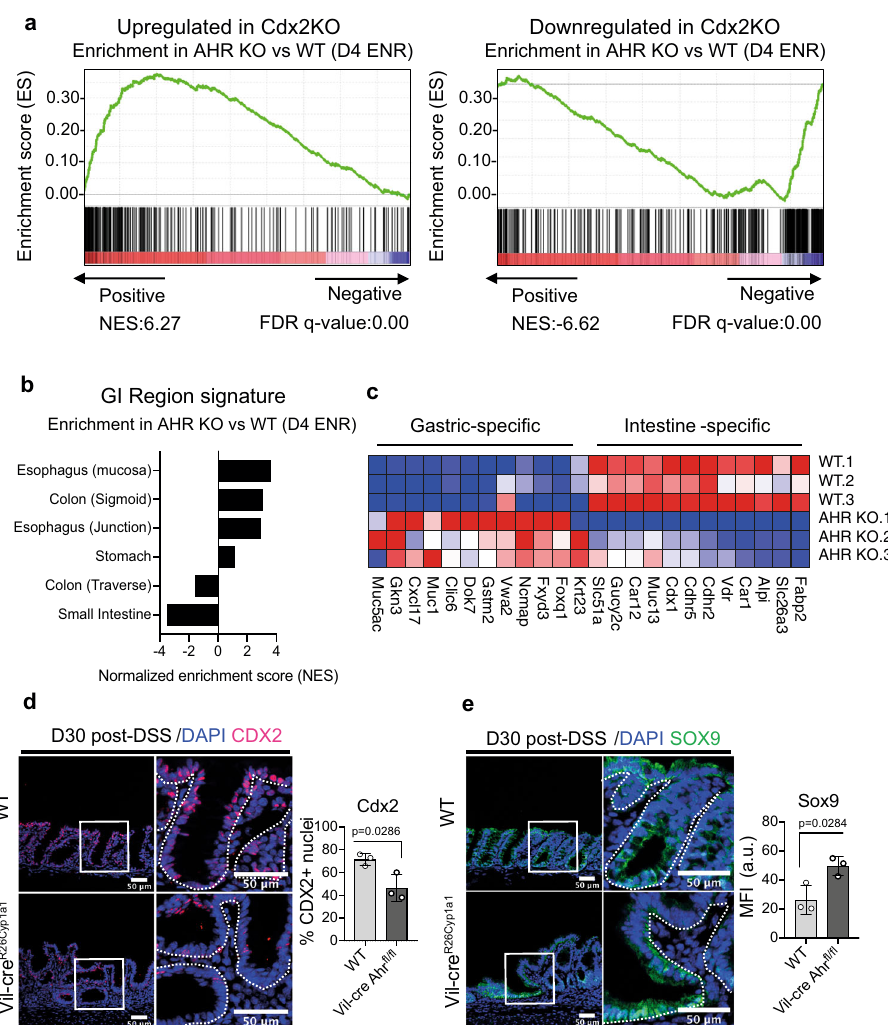
Fig. 7 AHR drives reacquisition of intestinal identity post-injury. a Gene set enrichment plots of AHR KO organoids relative to genes either upregulated (NES: 6.3, FDR q-value: 0.00) or downregulated (NES: -6.62, FDR q value: 0.00) in Cdx2 KO intestinal organoid dataset ( b ) Gene set enrichment of d4 ENR AHR KO vs WT organoids relative to conserved GI-region speci fi c signatures compiled from GiTEX database ( c ) Heatmap for expression of canonical genes expressed in either intestine or gastric tissues, in d4 ENR WT and AHR KO organoids. Representative images and quanti fi cations of Cdx2 ( d ) and Sox9 ( e ) staining in colonic crypts of WT and Vil-cre AHR fl / fl mice d30 post DSS treatment. Bar graphs show mean MFI ± SD per mouse for Sox9 and mean % of nuclei positive for Cdx2 per mouse ( n = 3 mice). Statistical signi fi cance was determined using an unpaired t-test (two-tailed). Error bars displayed on graphs represent the mean ± SD. Scale bar: 50 µ m. Source data for (7 d , e ) are provided with this paper in the source data fi